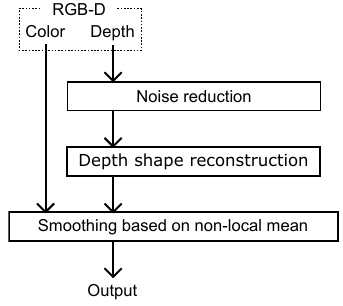
Figure 2. Outline of the proposed